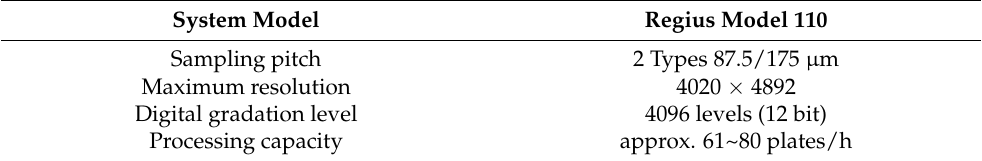
Table 3. Specifications of the CR